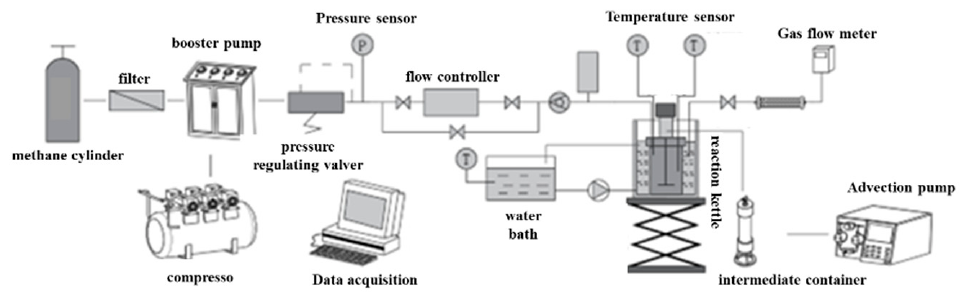
Figure 1. Schematic diagram of the composition of the gas hydrate synthesis and decomposition device.